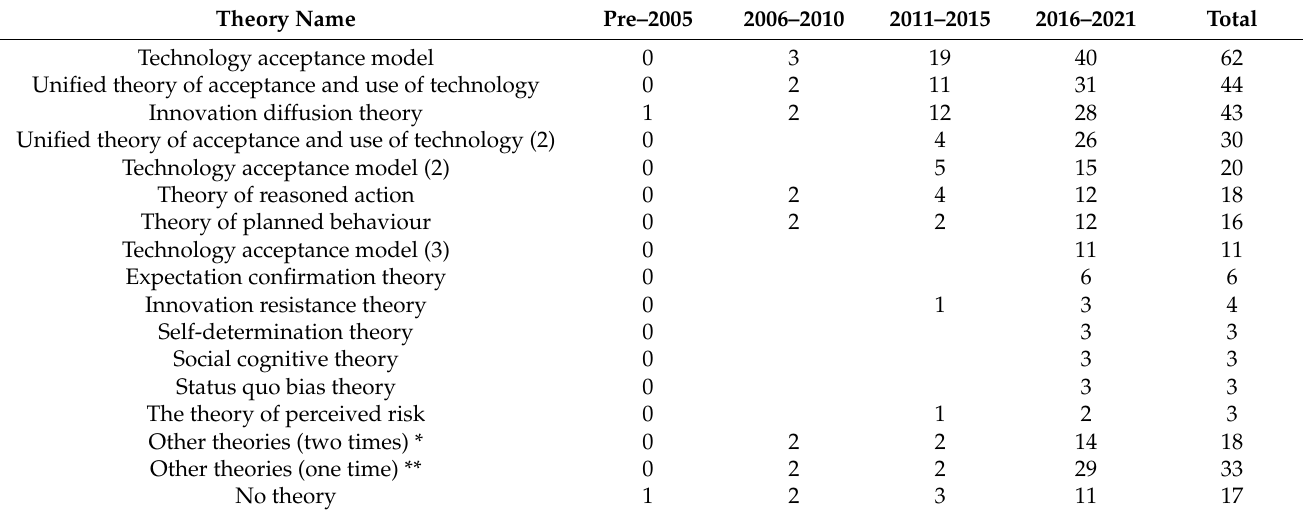
Table 1. Theoretical perspective in prior